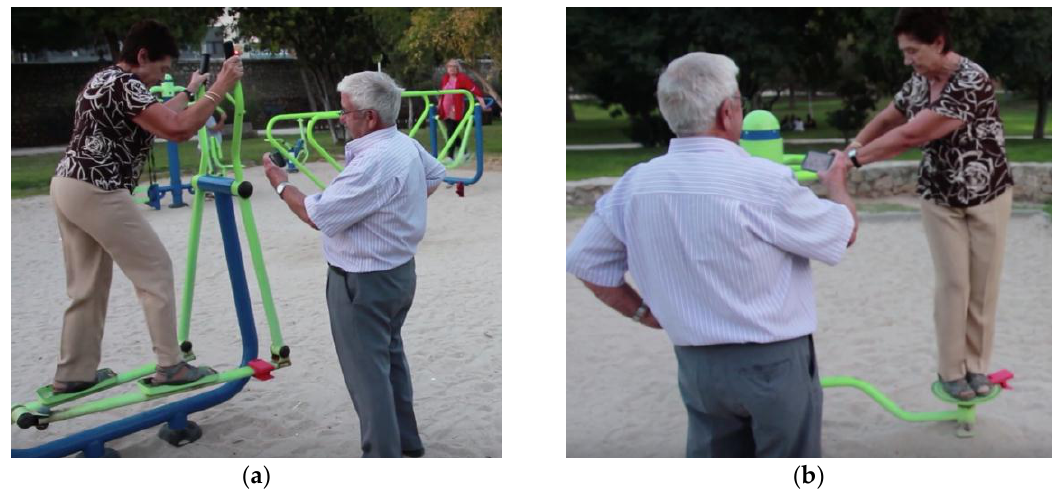
Figure 16. Seniors playing with HybridPLAY at the elliptical machine ( a ) and at the ab twister ( b ).